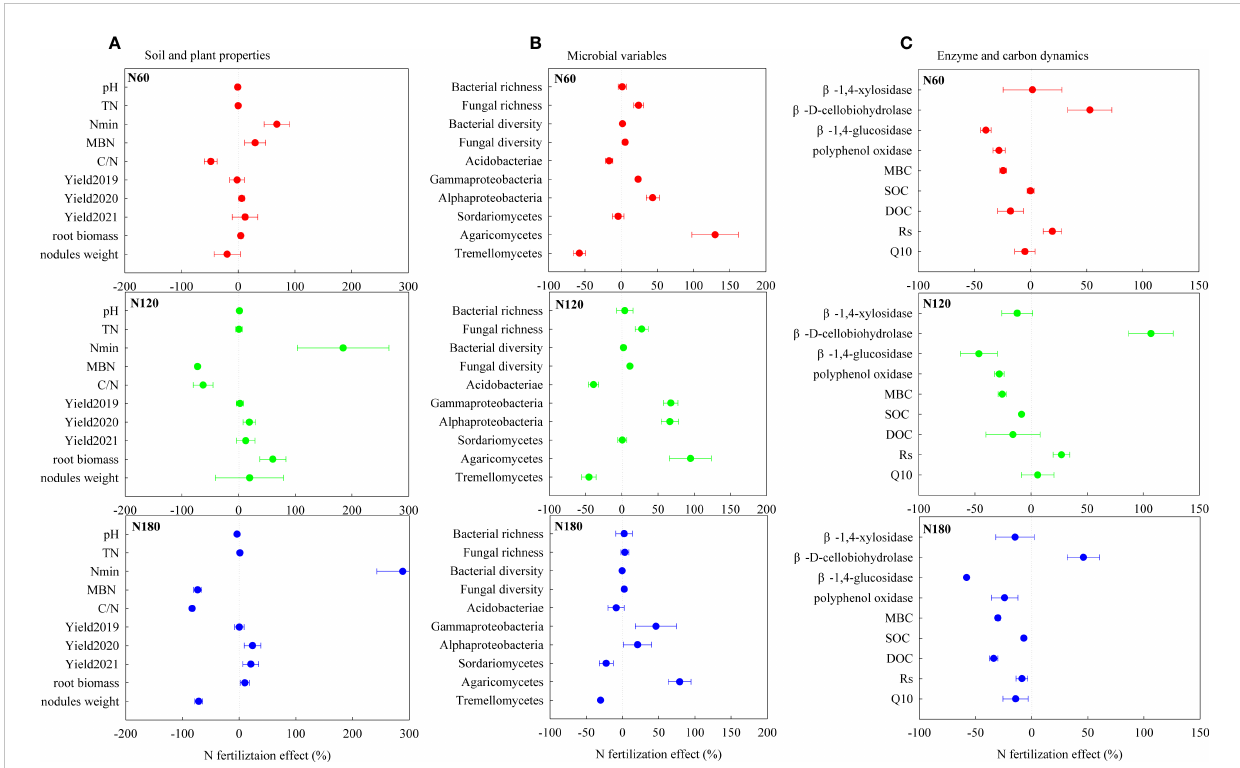
FIGURE 7 N fertilization induced changes (%) in soil and plant properties (A) , microbial variables (B) and enzyme and carbon dynamics (C) respectively at N60 (A1, B1 and C1), N120 (A2, B2 and C2) and N180 (A3, B3 and C3). SOC, soil organic carbon; DOC, dissolved organic carbon; N min , soil mineral nitrogen; TN, total nitrogen; C/N, soil carbon: nitrogen ratio; MBC, microbial biomass carbon; MBN, microbial biomass nitrogen. R s and Q 10 represent the soil respiration rate and its temperature sensitivity,